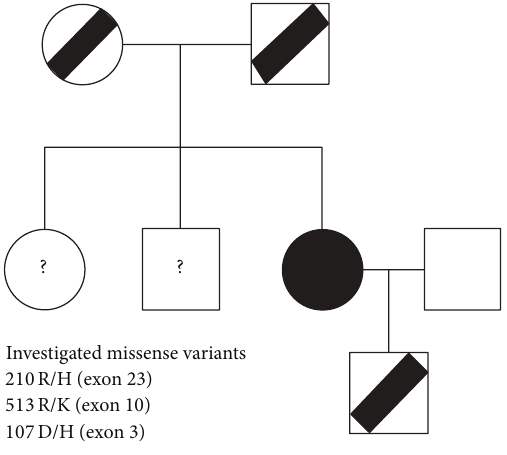
Figure 1: Segregation of 𝐹5 missense variants 2102 R/H (exon 23), 513 R/K (exon 10) and 107 D/H (exon 3). Half-filled symbols indicate heterozygotes for investigated mutatons. Completely filled symbols indicate homozygous for all investigated mutations (i.e., proband). Open symbols indicate no carrier of investigated mutations. Ques- tion marks indicate that genotyping has not been